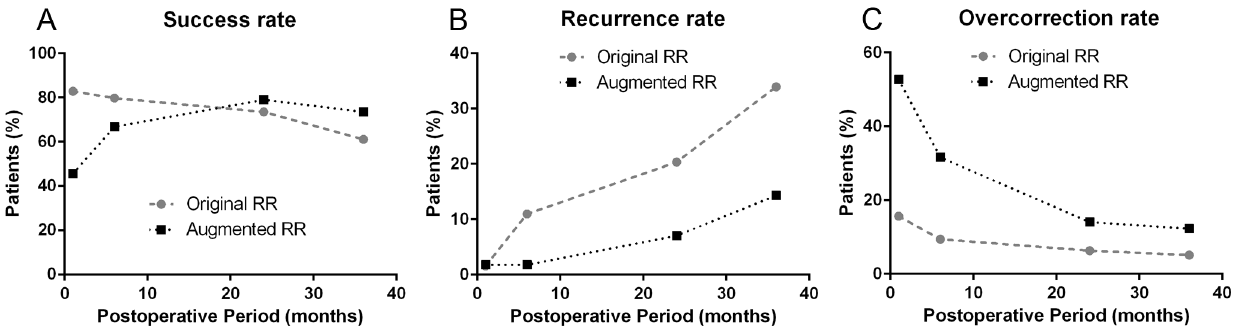
Fig 1. Surgical outcomes. Percentageof patients resulting in success ( A ), recurrence( B ) and overcorrection( C ) at 1 month, 6 months, 2 years and 3 years after the originalunilaterallateral rectus recession-medial rectus resection(RR) and augmentedRR.